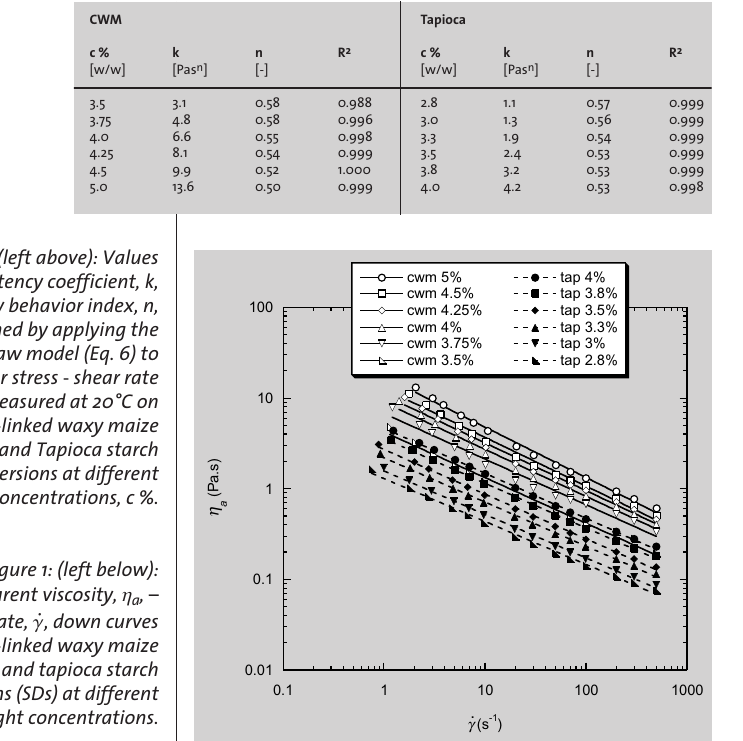
Figure 1: (left below): Apparent viscosity, h a , – shear rate, g · , down curves for cross-linked waxy maize (CWM) and tapioca starch dispersions (SDs) at different weight